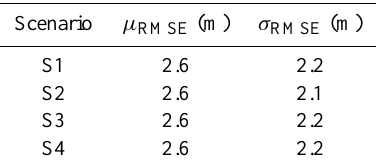
Table 3. RMSE of simulated hydraulic head against observations. The table lists mean, µ RMSE , and standard deviation, σ RMSE , over 50 realizations (where each RMSE value is based on 219 observa- tion